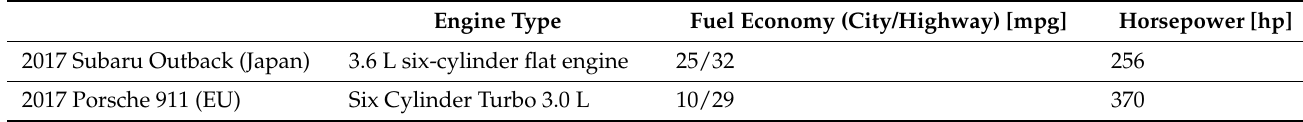
Table 3. The main characteristics of various flat engines.